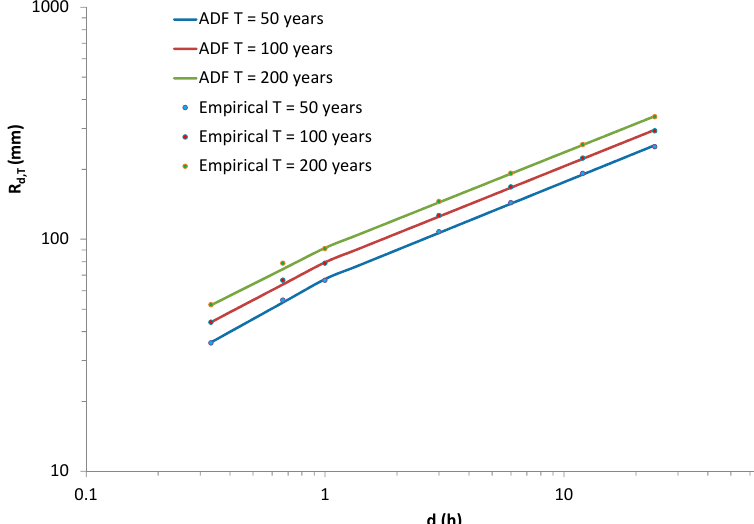
Figure 2 . EV1 probability plot of 20-min annual maxima H at basin scale: comparison between observed (estimated by using the technique of Voronoi polygons) and generated series for Corace at Grascio.